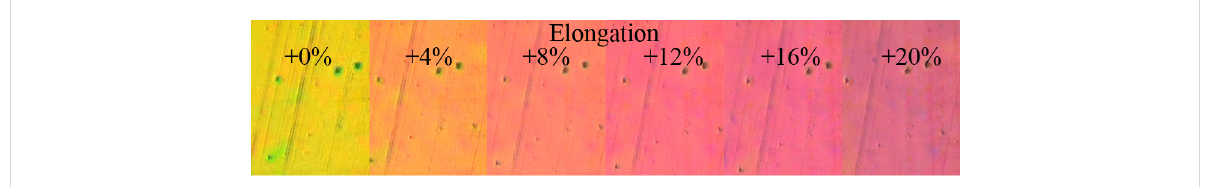
Figure 5: Photographs of the 6 wt % TiO 2 sample at strain values of 0 to 20% taken with crossed polarization filters.